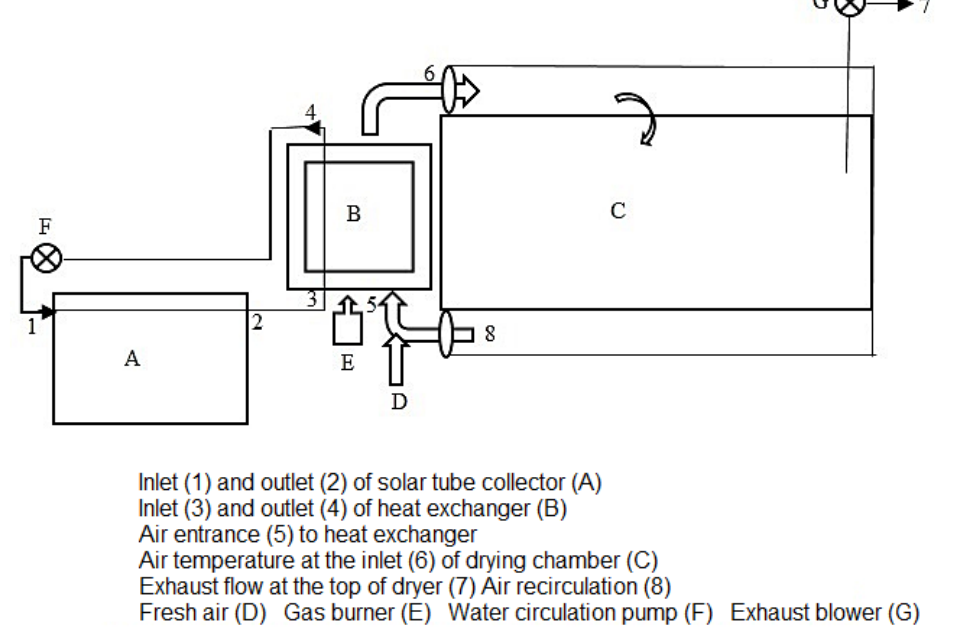
Figure 3. Schematic illustration of different components of dryer and streams with marked points used in equations for the exergy analysis (conventional and advanced).